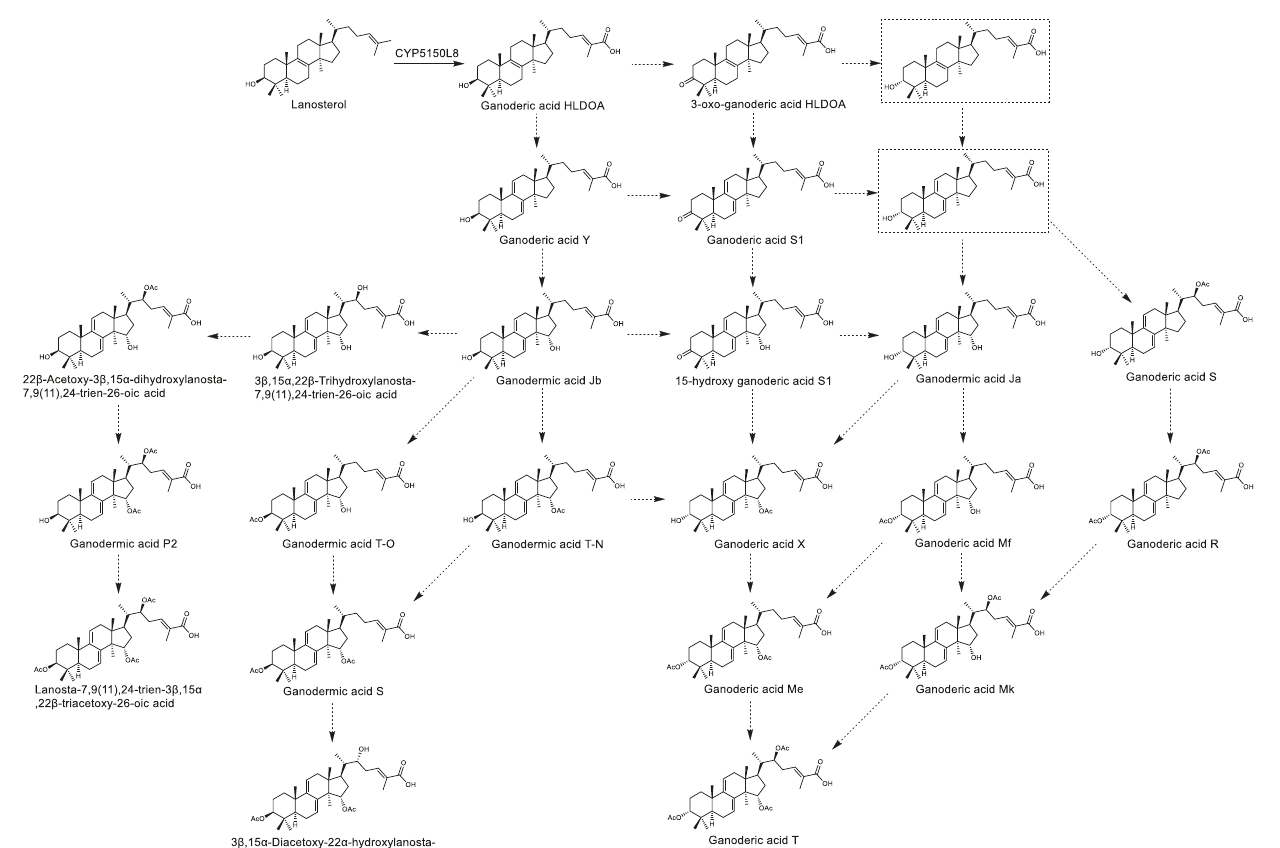
Fig.1|ProposedbiosyntheticpathwayoftypeIIGAsfromlanosterol. Thesolid arrow indicates that the catalytic activity of the enzyme has been con fi rmed. The dotted arrow indicates the proposed catalytic reactions. The dotted rectangle borders indicate the proposed intermediates. (24 E ) − 3-oxo-5 α -lanosta-7,9(11),24-